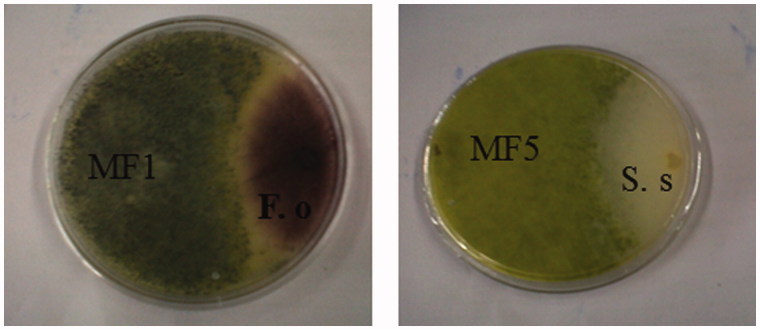
Dual culture bioassay of endophytic fungi of Markhamia tomentosa against Fusarium oxysporum (F. o; ITCC 3636) and Sclerotinia sclerotorium (S. s; ITCC 6323).